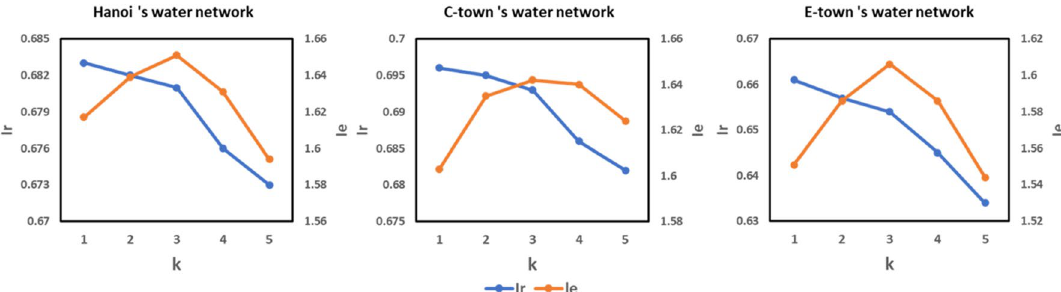
Figure 6. Influence of the aggregate node information process on WNP.